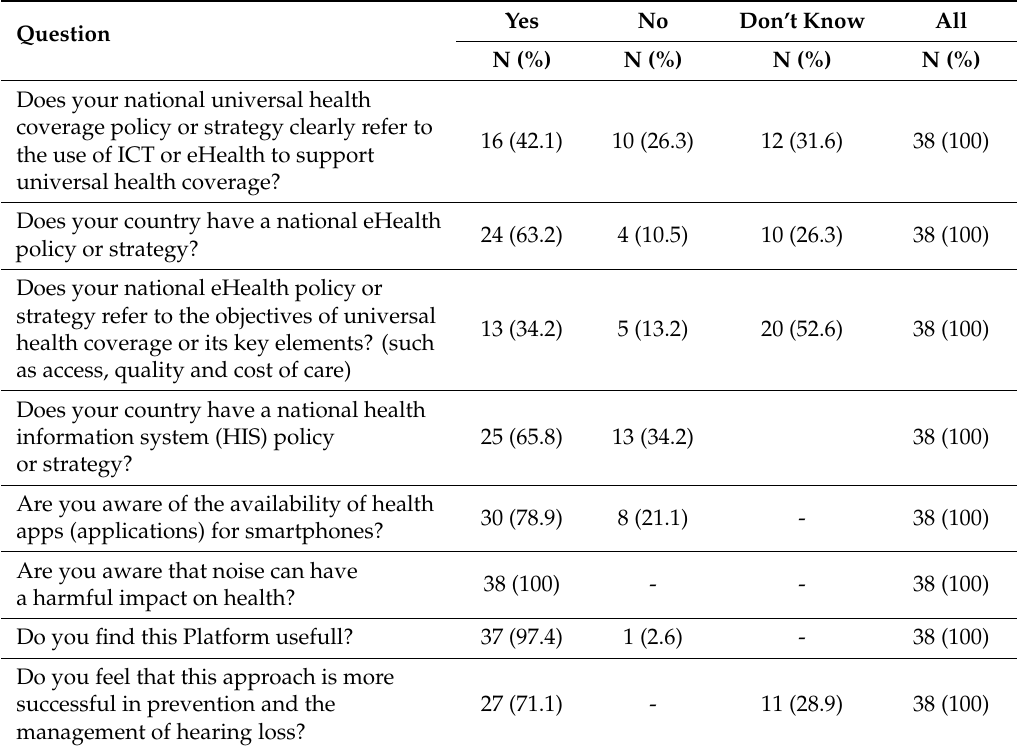
Table 4. What should be the primary measurable objectives of an e-health system? (you can answer more than one).